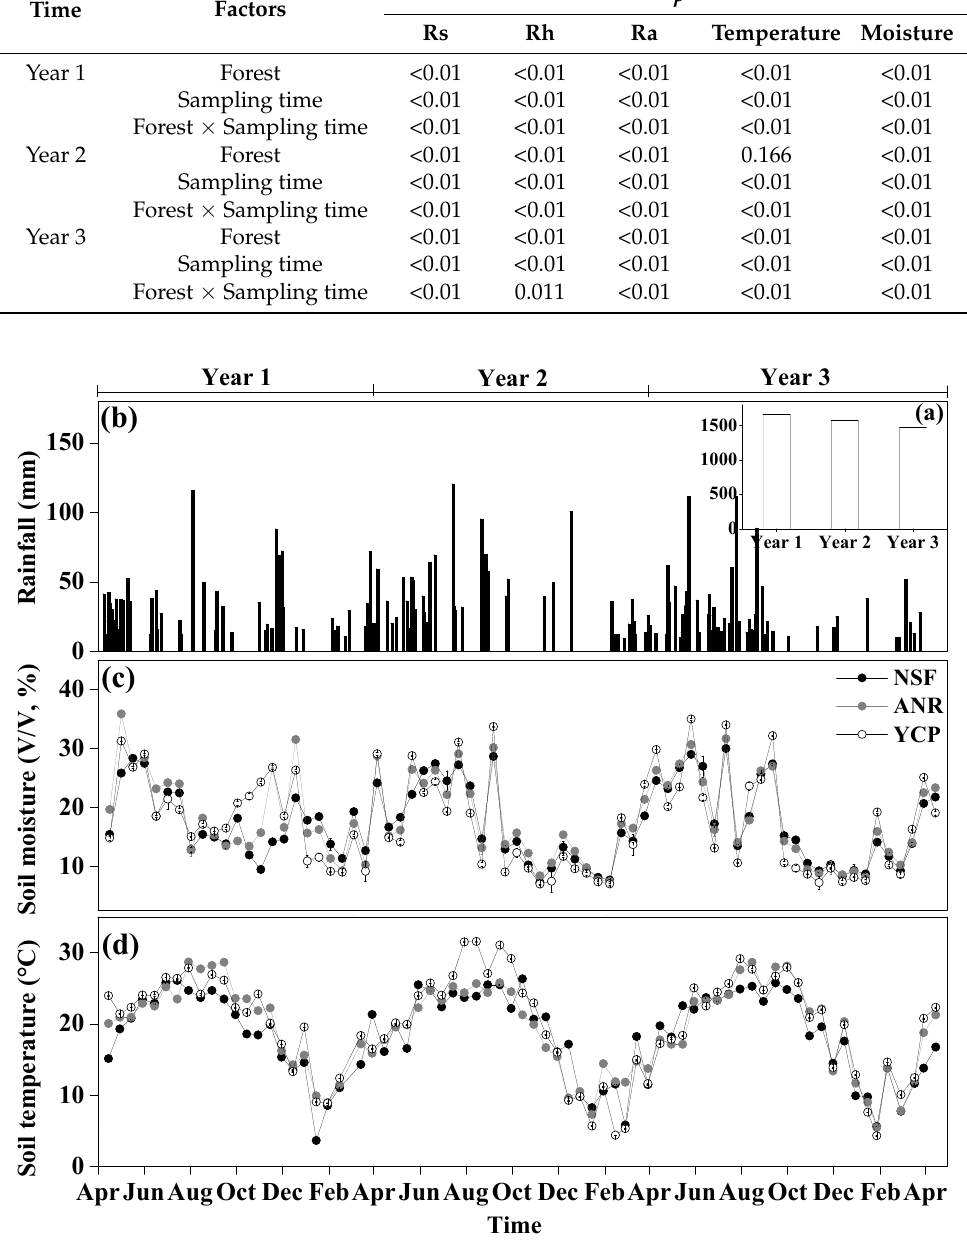
Figure 1. Variation in rainfall, soil temperature, and soil moisture at a depth of 5 cm from 15 April 2012 to 15 April 2015, in a natural secondary forest (NSF), a young forest established through assisted natural regeneration (YNR), and a young Castanopsis carlesii plantation (YCP) (mean ± standard deviation, n = 3).